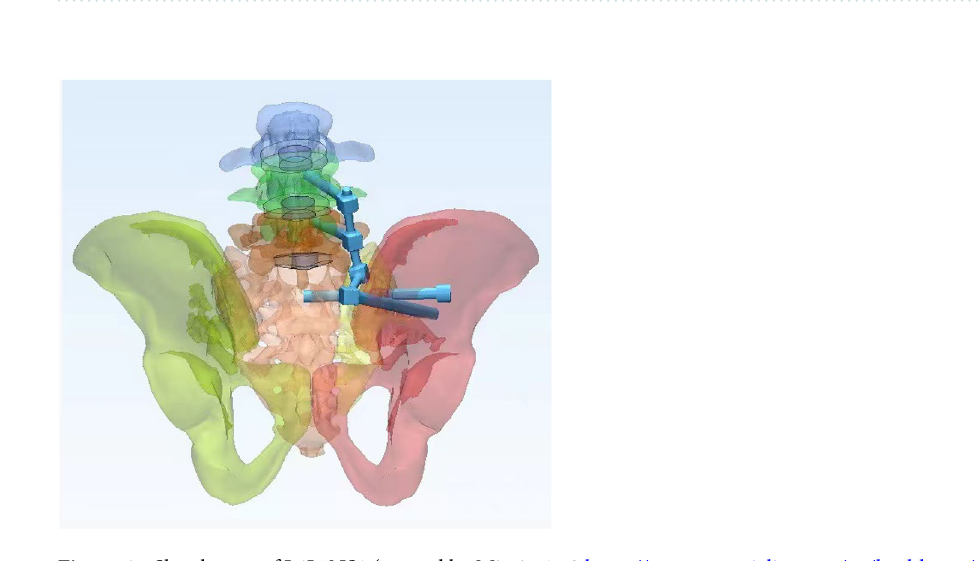
Figure 4. Sketch map of L4L5NS1 (created by Mimics17.0 https:// www. mater ialise. com/ en/ healt hcare/ elect ronic- instr uctio ns- for- use/ mimics- resea